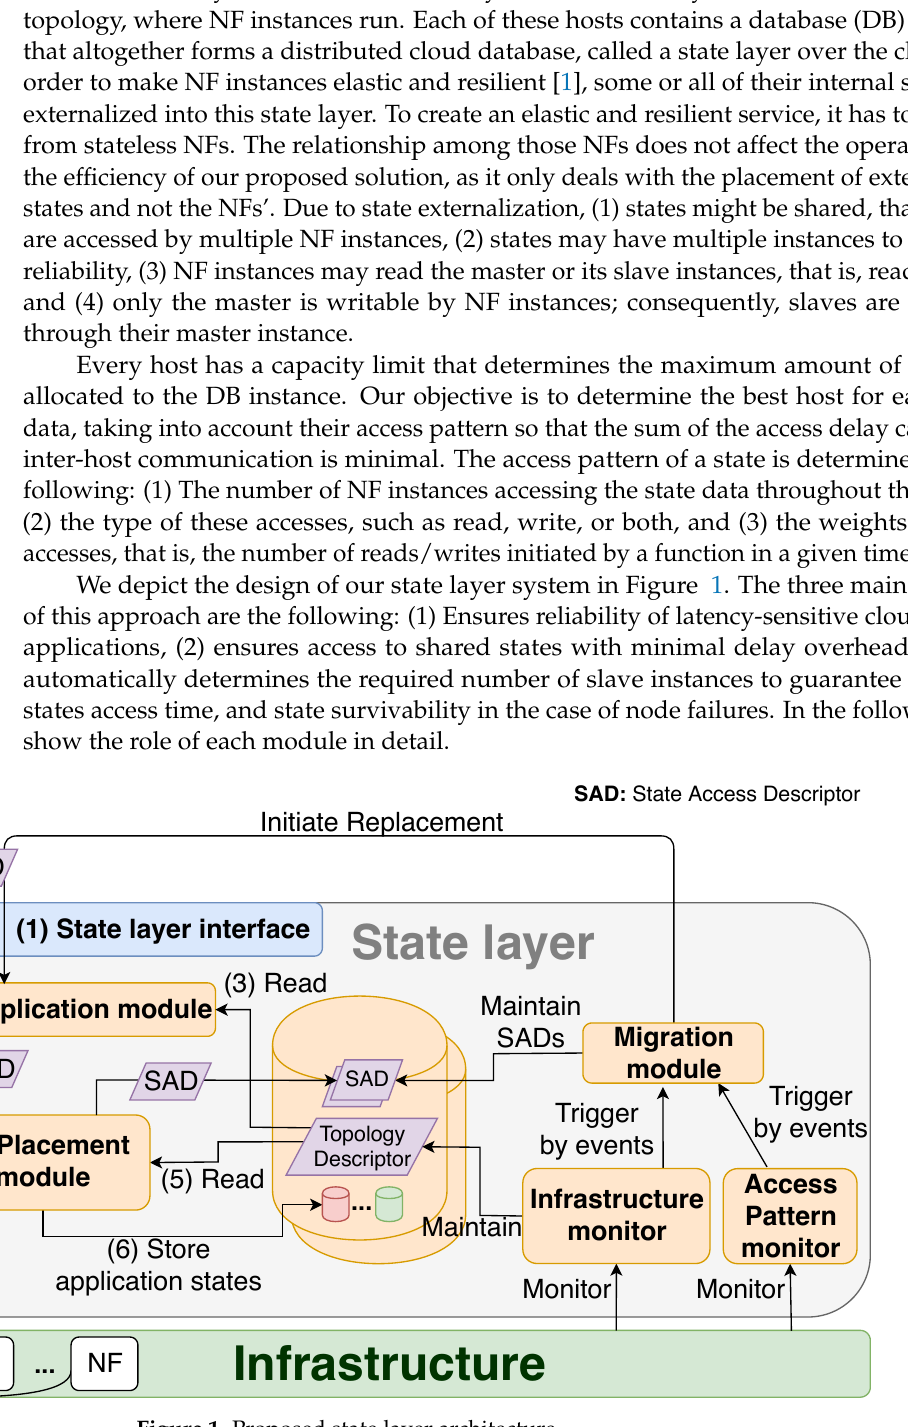
Figure 1. Proposed state layer